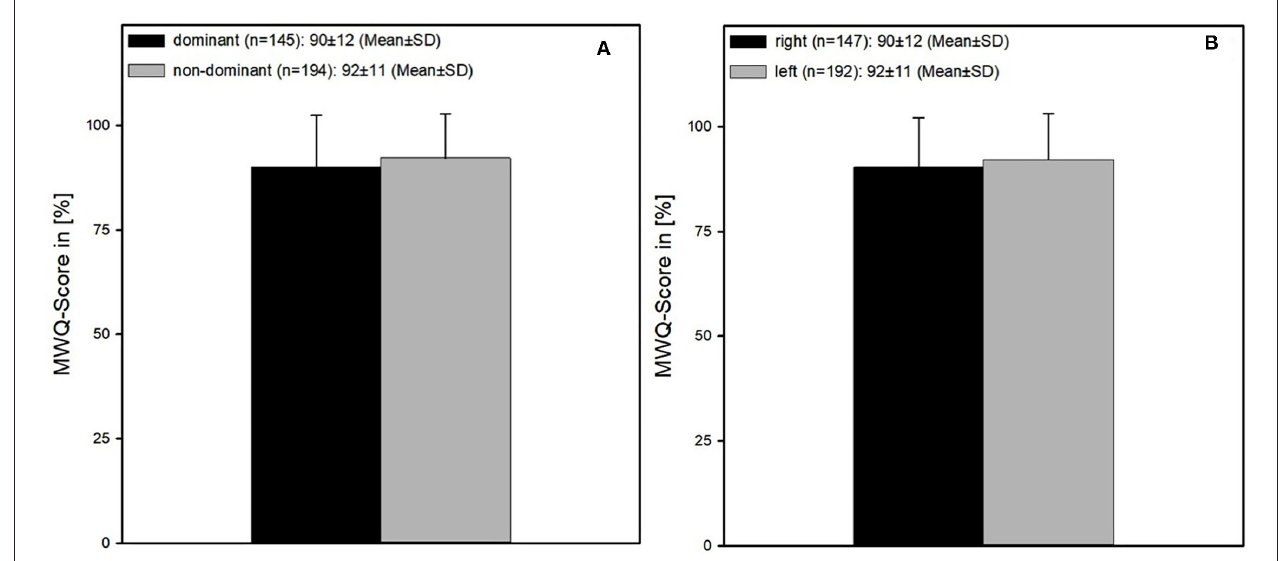
FIGURE 7 | (A) Comparing the function after a fracture of the dominant and non-dominant wrist, respectively. The outcome of the dominant wrists was worse compared to the non-dominant wrists (90 ± 12 vs. 92 ± 11%, p < 0.072 MWUT). (B) Comparing the function after a fracture of the left and right wrist, respectively. Results after a fracture of the right wrist were worse compared to the fractures of the left wrist (90 ± 12 vs. 92 ± 11%, p < 0.064 MWUT).